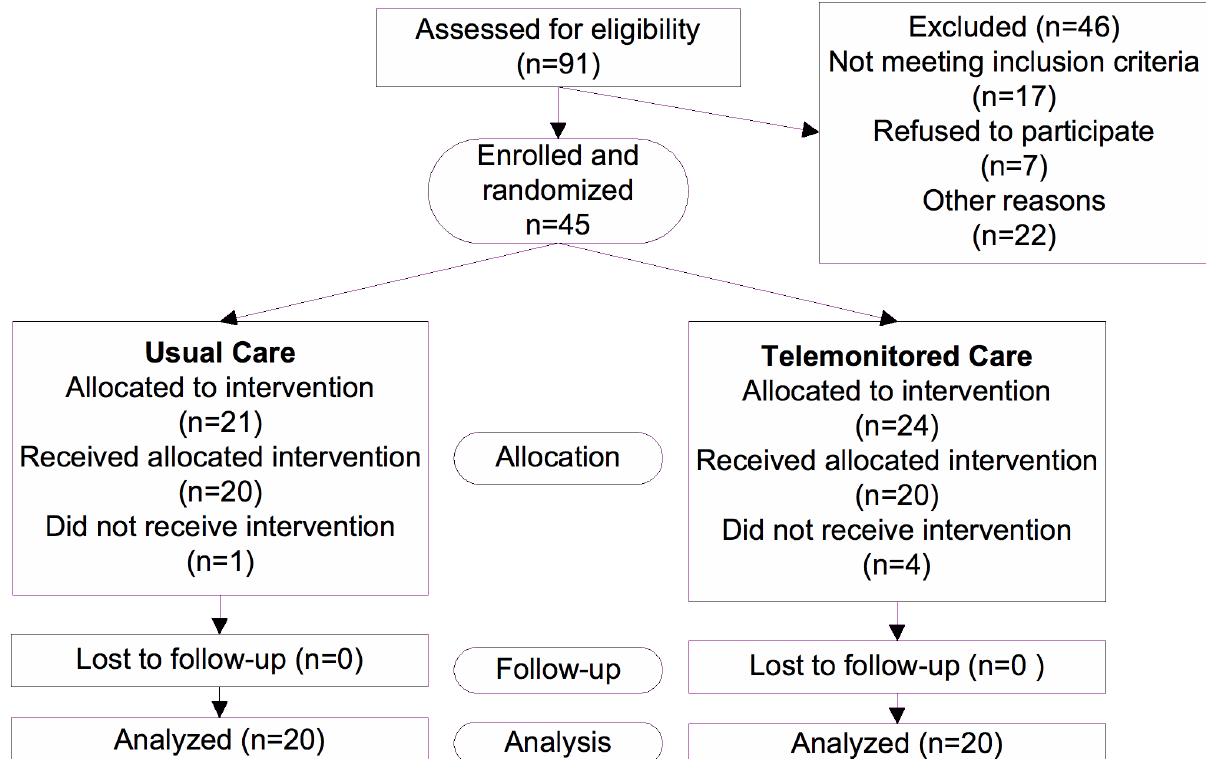
Figure 1. Participant flow and randomization